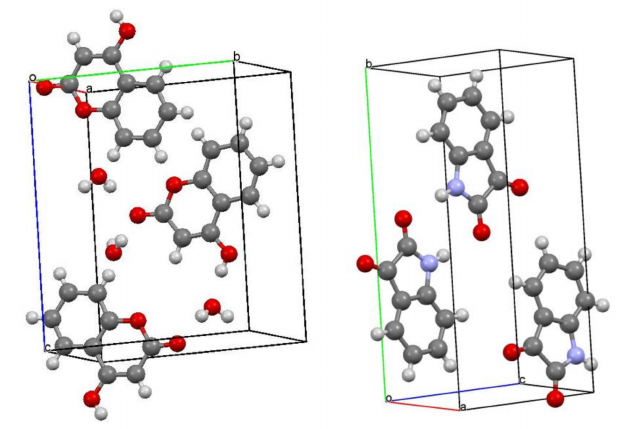
Figure 5. Crystal packings of ( left ) CA1 and ( right ) CA4